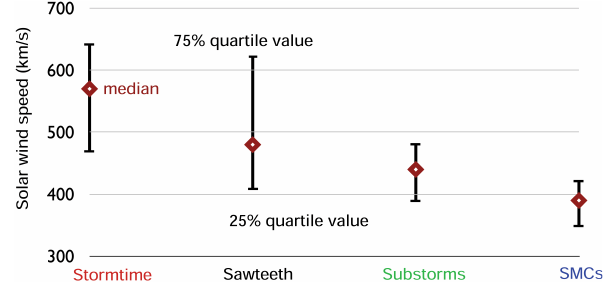
Fig. 7. Median (red diamonds), 25% and 75% quartile (black error bars) velocities for the subgroups of SMCs (blue), isolated substorms (green), sawtooth events (black) and storm-time activa- tions (red), for which the driving solar wind E Y ranges from 1.5 to